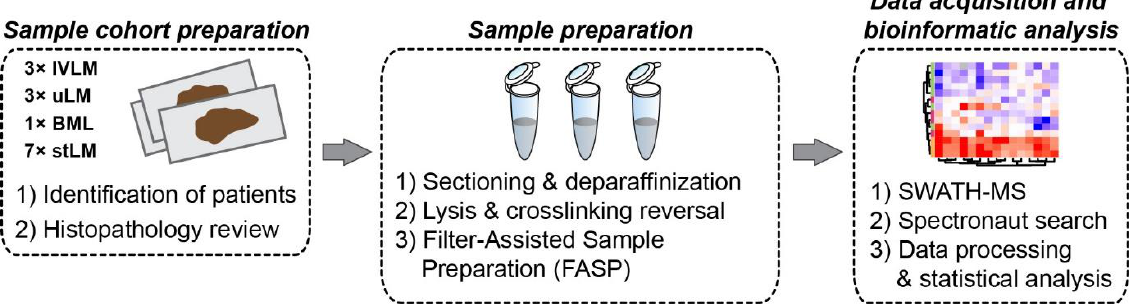
Figure 1. Experimental workflow depicting key procedures of sample selection and preparation, proteomic data acquisition and subsequent data processing and analysis.